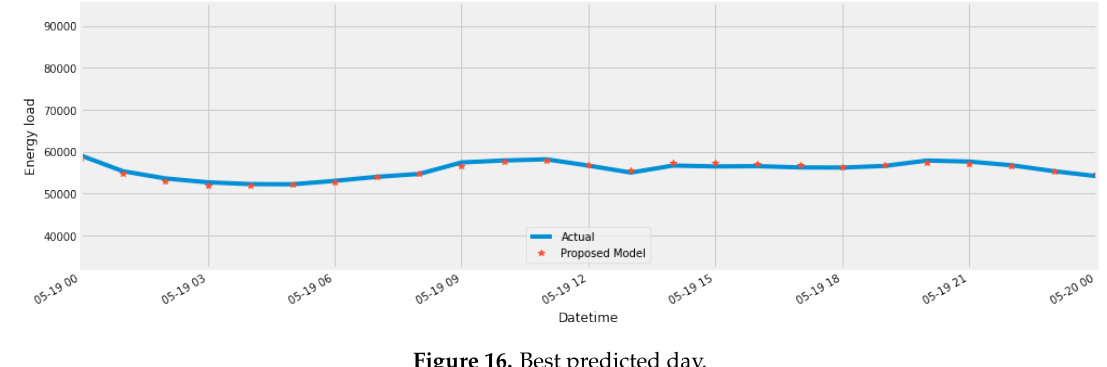
Figure 16. Best predicted